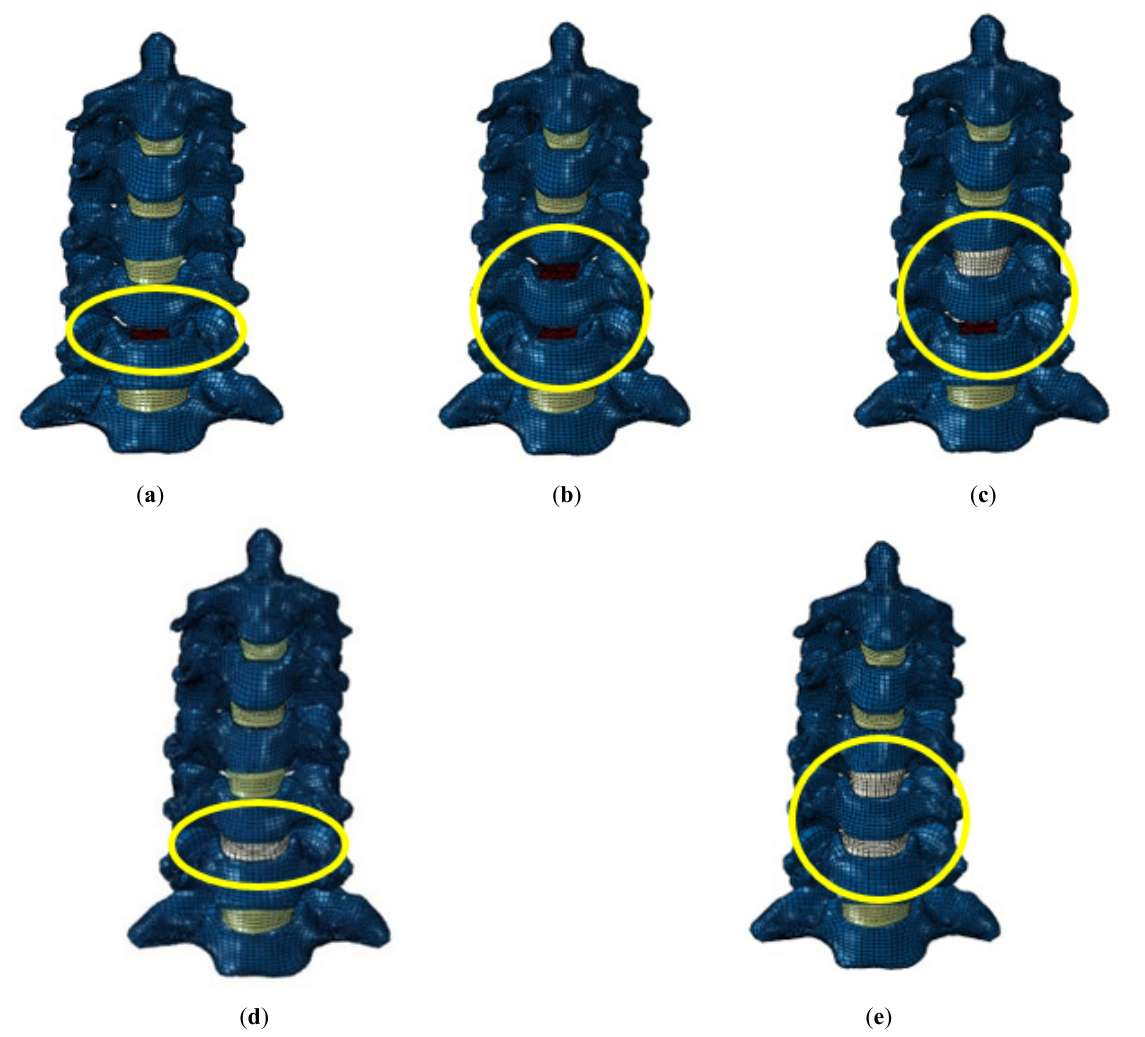
Figure 2. ( a ) C5–C6 dynamic cervical implant (DCI) model; ( b ) C4–C6 DCI model; ( c ) hybrid surgery model; ( d ) C5–C6 ‐ fused model; ( e ) C4–C6 ‐ fused model.